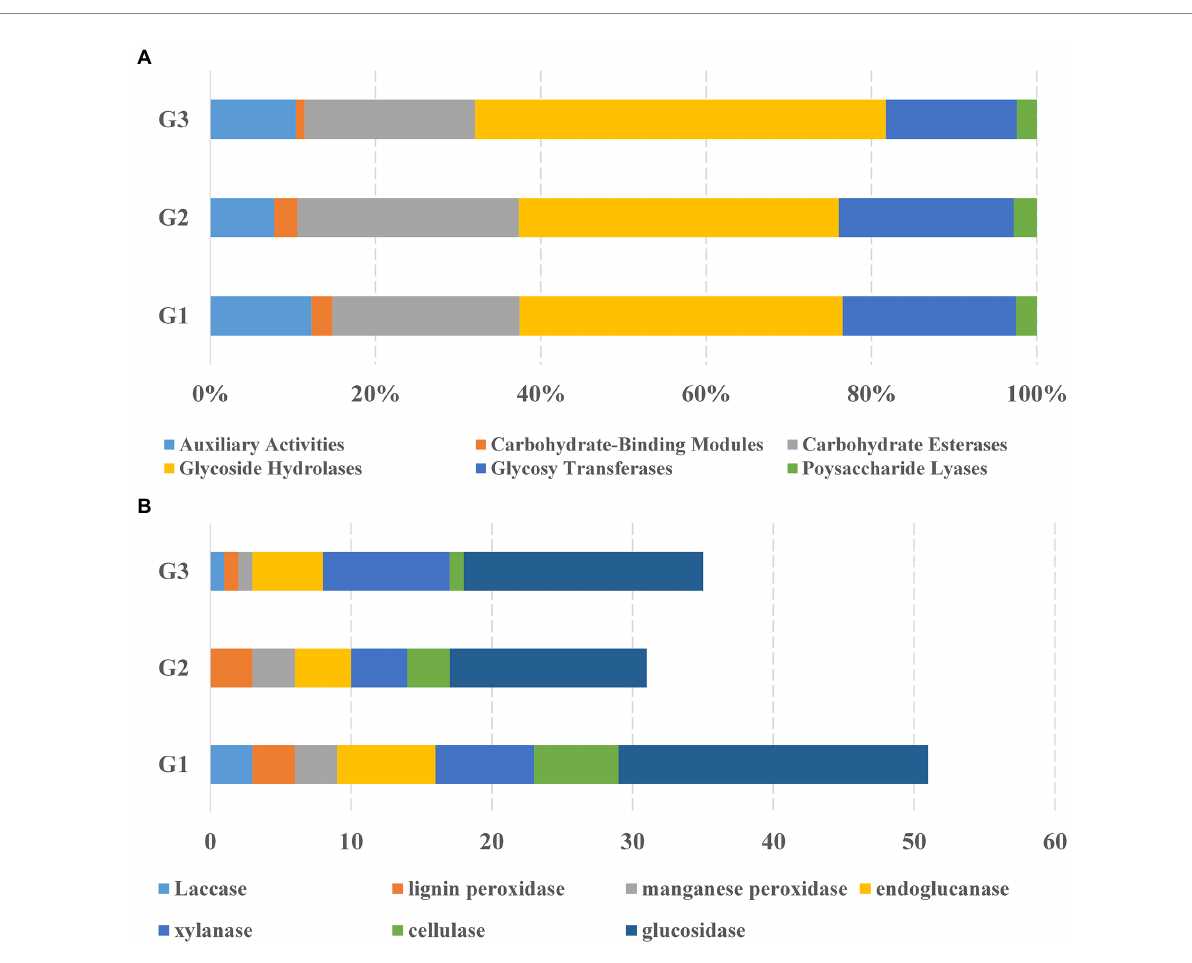
FIGURE 3 Comparative analysis of CAZyme of the species Streptomyces sp. G1 T , Streptomyces sp. G2 T and Streptomyces sp. G3 T . (A) The percentage of CAZymes in three biodegradable species distributed on six categories of enzyme activity: auxiliary activities, carbohydrate-binding molecules, carbohydrate esterases, glycoside hydrolases, glycosyltransferases, and polysaccharide lyases; (B) The total number of the CAZyme sets related to corn straw decomposition in the genomes of species Streptomyces sp.